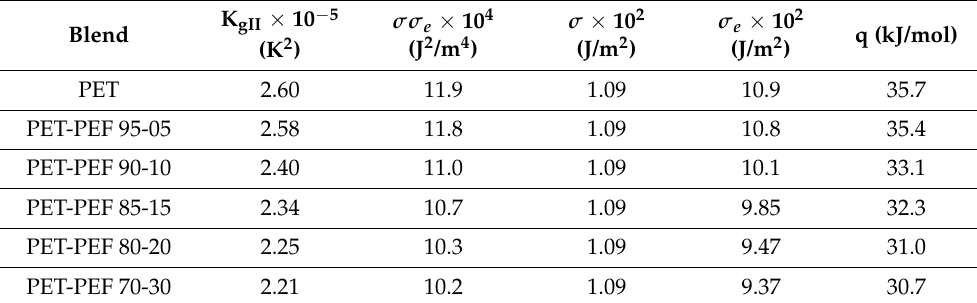
Table 1. Results from the Lauritzen-Hoffman analysis on the crystallizable blends.